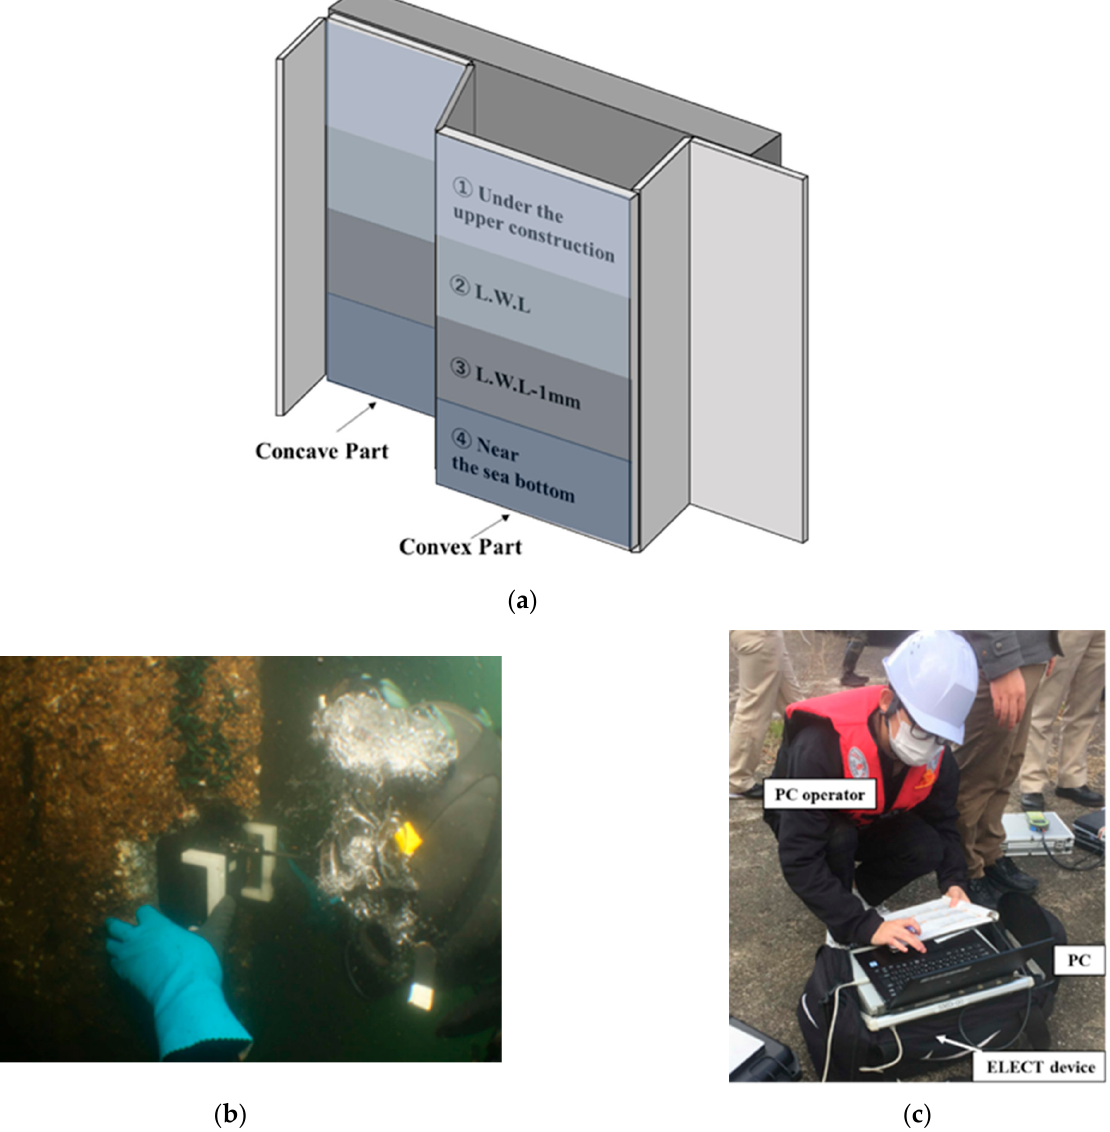
Figure 11. ( a ) Schematic of a steel sheet pile; ( b ) Photographs of the diver measuring a steel sheet pile in water; ( c ) PC operator. Table 1. Comparisons of estimated